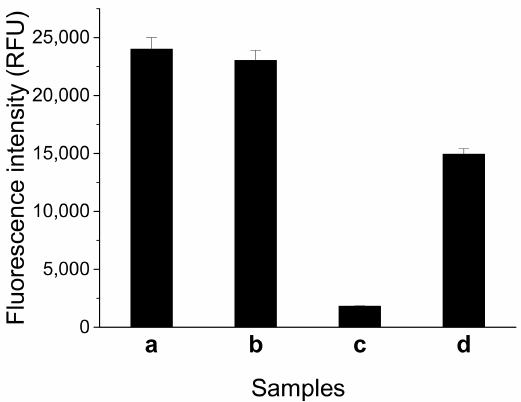
Figure 2. Feasibility test of the fluorescent switch aptasensor for AFB1 detection by measuring differ- ent samples. ( a ) FDNA; ( b ) FDNA+QDNA; ( c ) FDNA+QDNA+aptamer; and ( d ) FDNA + QDNA + aptamer + AFB1. Assay buffer was 10 mM Tris-HCl (pH 7.5) solution containing 50 mM MgCl 2 , 50 mM NaCl, and 0.1% Tween 20. FDNA concentration was 50 nM. Aptamer (Af27) concentration was 100 nM. QDNA (Af27-C13Q) concentration was 100 nM. AFB1 concentration was 200 nM. Incubation at 4 ◦ C for 60 min was